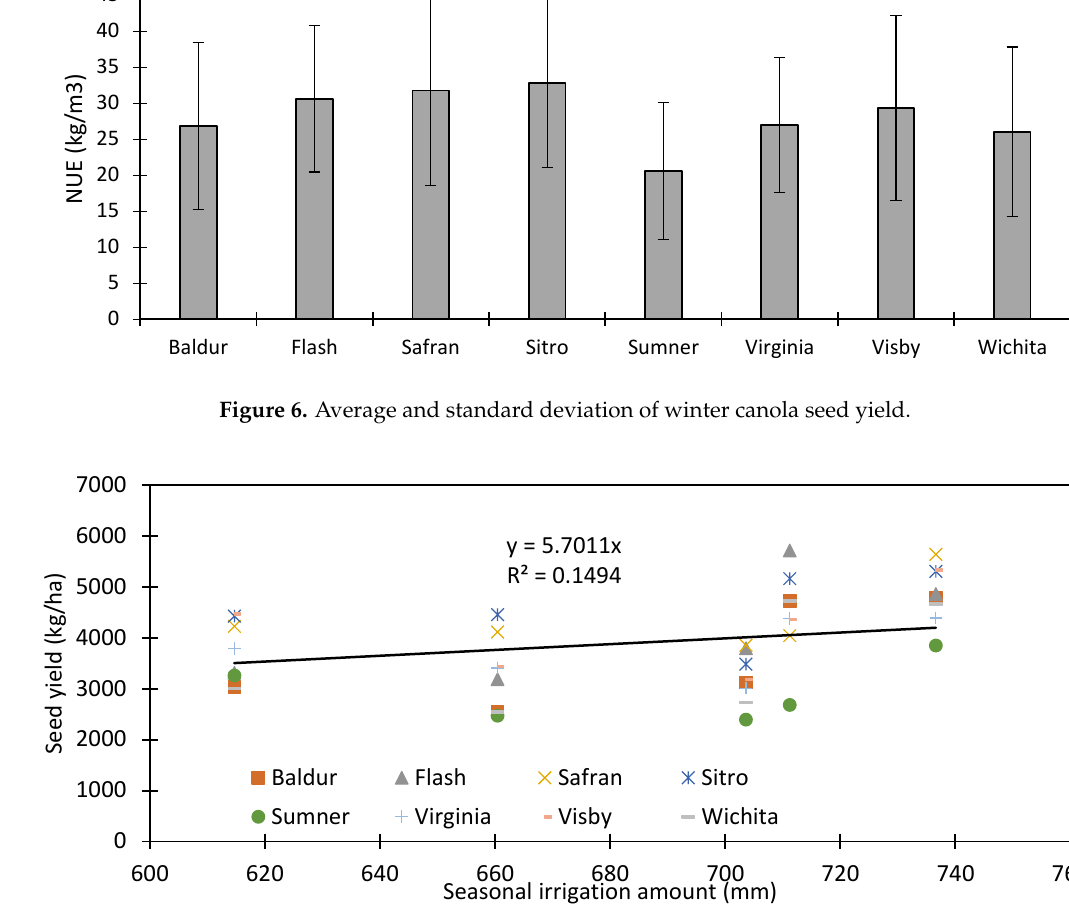
Figure 7. Relationship between winter canola seed yield and seasonal irrigation amount.